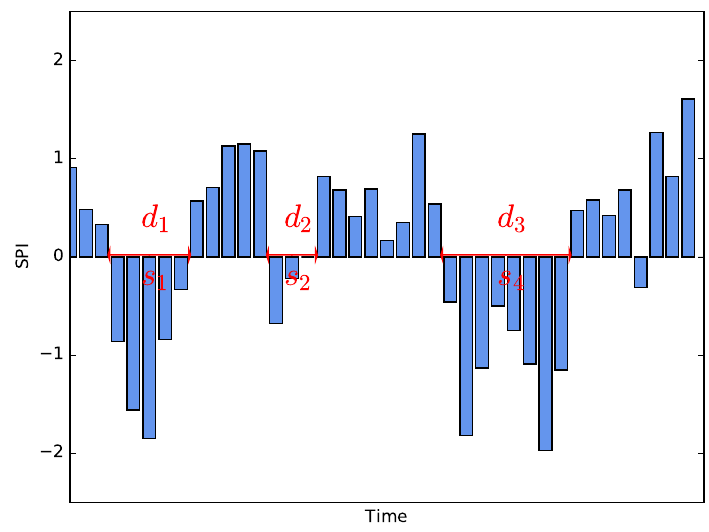
Figure 2. Definitions of drought characteristics.